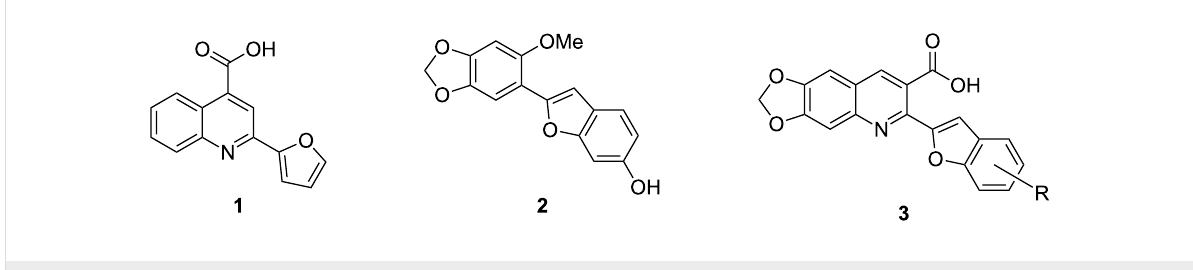
Figure 1: Structures of compounds 1 , 2 and 3 .